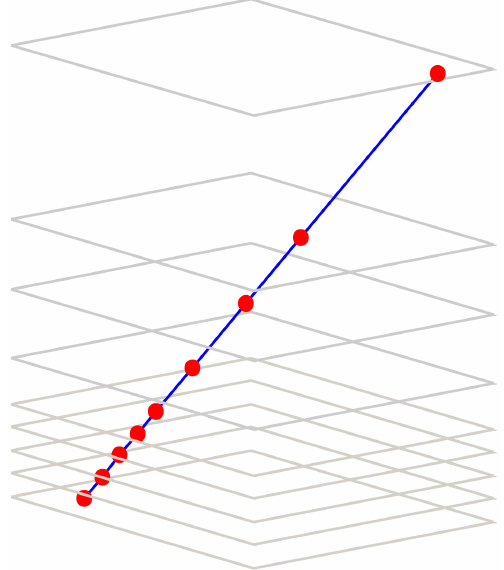
Figure 1. Vertical structure of IDW tomography model and the sig- nal rays (blue line) crossing the vertical layers. The value of SWV divides into the value of water vapor at pierce points (red points).